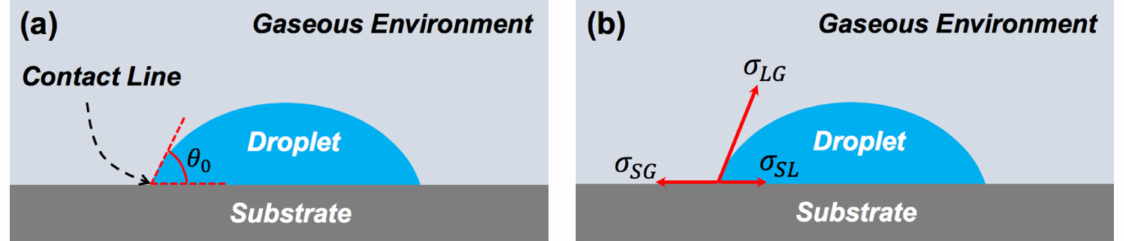
Figure 1. ( a ) Schematic representation of the contact line and the static contact angle. ( b ) A droplet, deposited on a substrate, is in the equilibrium state with the balance of the interfacial tensions along the contact